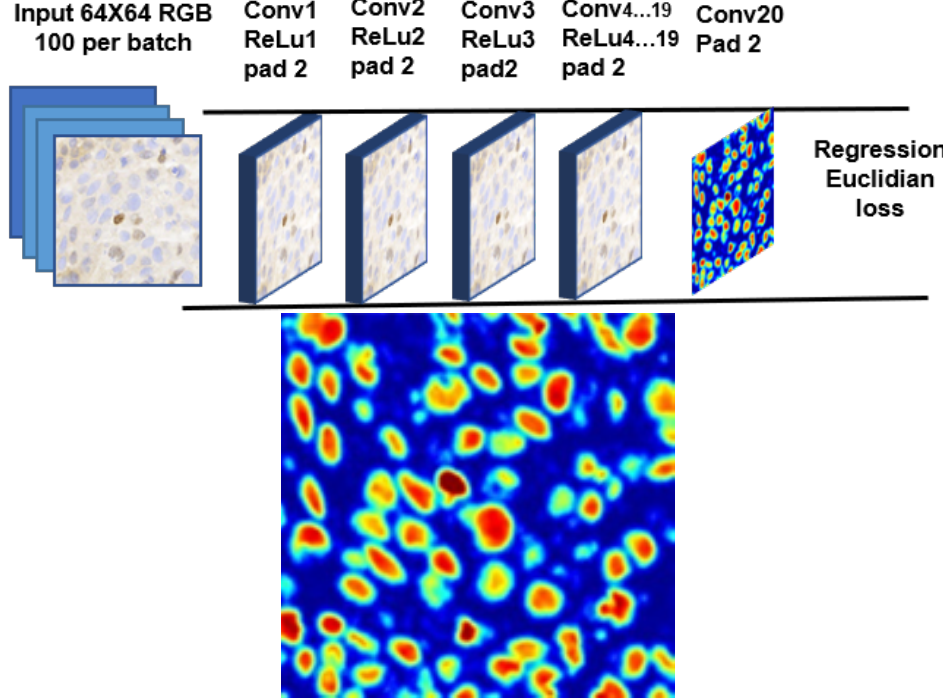
Figure 2. CNN model for cell detection, with regression layer at the end of the network ( top ), and the generated score map at 20 × magnification ( bottom